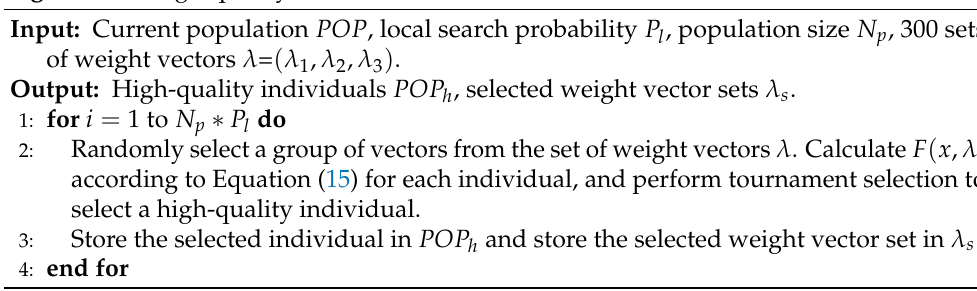
Algorithm 3 High-quality individual